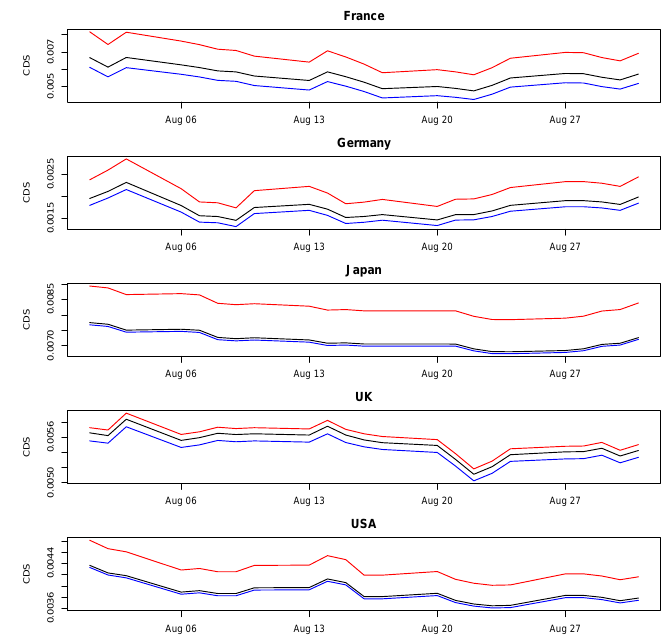
Figure 7. August 2012, predictive performance for peripheral countries. For each considered peripheral country, the graphs report the observed CDS spreads at time t (black line), the CDS spreads predicted at time t − 1 using the proposed model (red line) and the CDS spreads predicted at time t − 1 using only the autoregressive component (blue line).